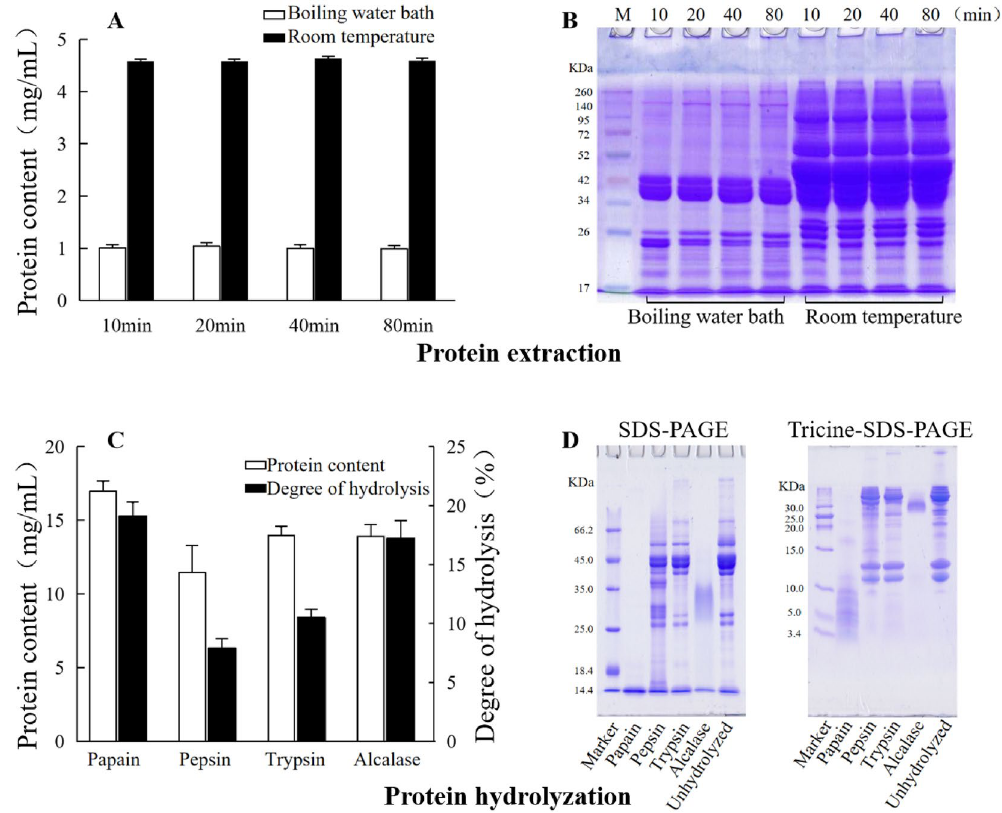
Figure 1. Extraction and hydrolysis of crocodile meat proteins. ( A ) Soluble protein contents extracted with water at room temperature or on boiling water bath; ( B ) SDS-PAGE analysis of soluble proteins extracted at temperature or on boiling water bath; ( C ) Protein contents and hydrolysis degree of crocodile meat hydrolyzed by different enzymes; ( D ) SDS-PAGE and tricine-SDS-PAGE analyses of the hydrolysates by different